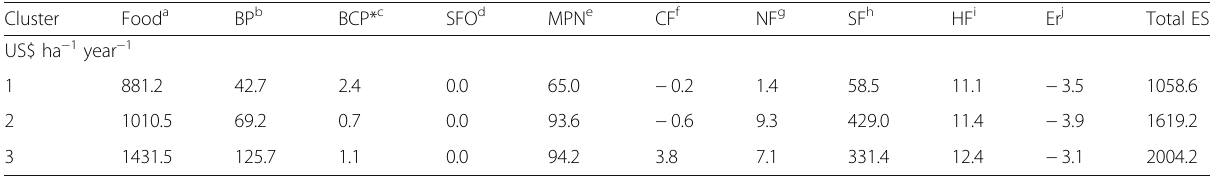
Carbon flow g Nitrogen fixation h Soil fertility i Hydrological flow j Soil